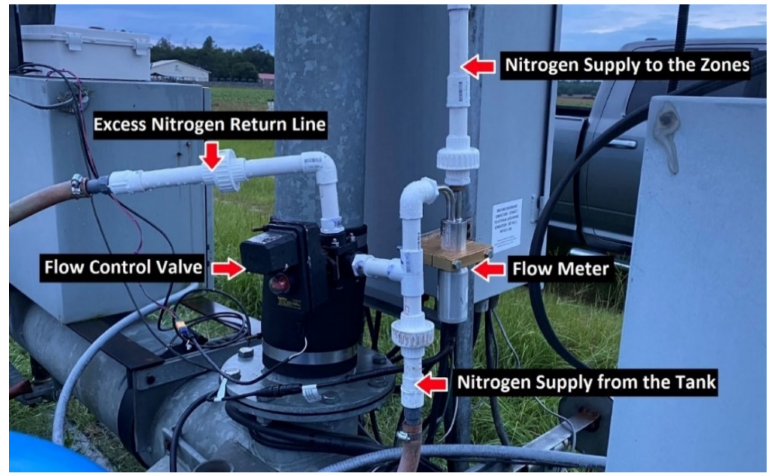
Figure 4. The flow control bypass system mounted on the lateral’s mainline.